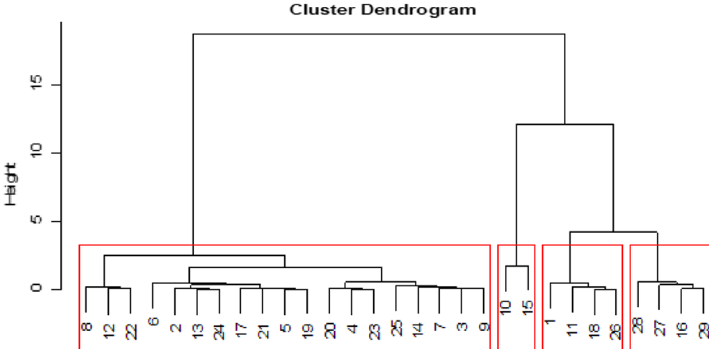
Fig. 14 Cluster dendrogram with spatial correlations in Stage 1. Note The numbers 1, 3, 12, 14, 16, and 23, 26 denote stock indices in developed markets; the remaining numbers denote indices in developing markets, according to Tables 2 and 3